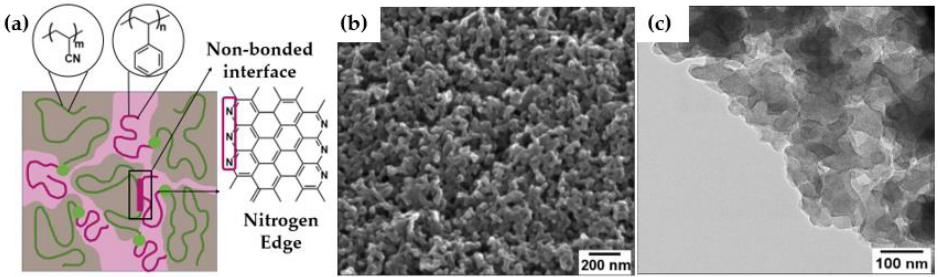
Figure 2. ( a ) Scheme of disordered morphology of PS − b − PAN upon uncontrolled phase-separation, ( b ) SEM image of bulk material after carbonization, ( c ) TEM image of bulk carbon material.